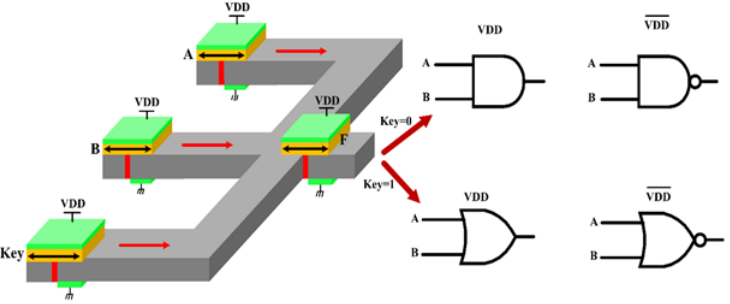
Figure 39. All ‐ spin logic (ASL) AND, OR, NAND, and NOR polymorphic gates. Figure 39. All-spin logic (ASL) AND, OR, NAND, and NOR polymorphic gates.